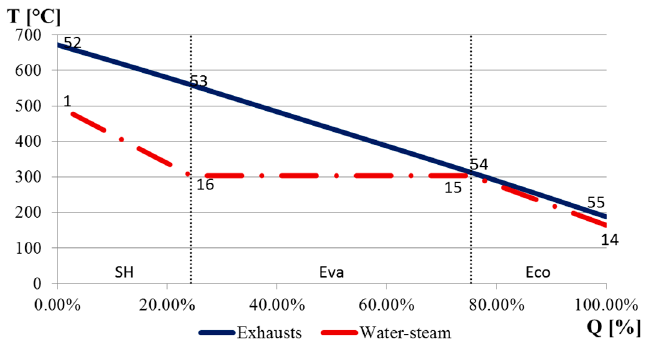
Figure 9. The heat-temperature diagram for HRSG of the CC ´ 2G + SF combined Figure 9. The heat ‐ temperature diagram for HRSG of the CC − 2G + SF combined cycle.